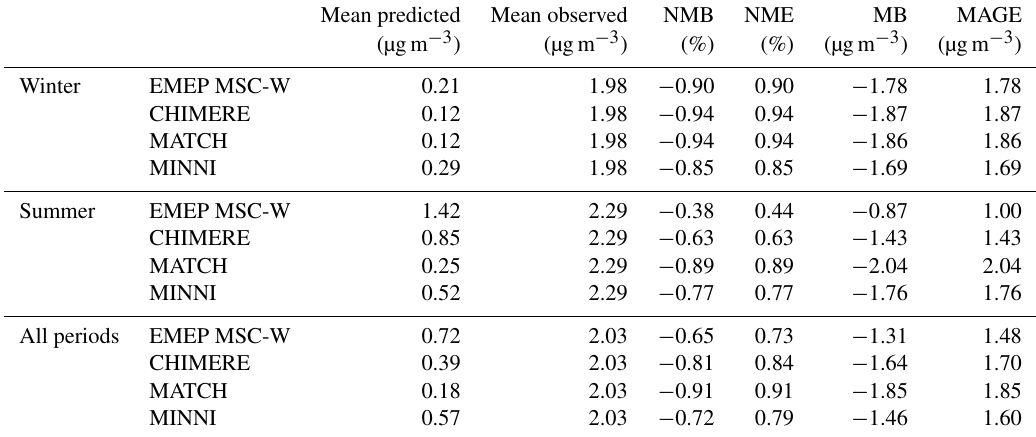
Table 7. Observed and predicted SOA concentrations, averaged over all sites (Table S2 and Fig. S1), and for the summer and winter cam- paigns. Statistics are normalized mean bias (NMB), normalized mean error (NME), mean bias (MB) and mean absolute gross error